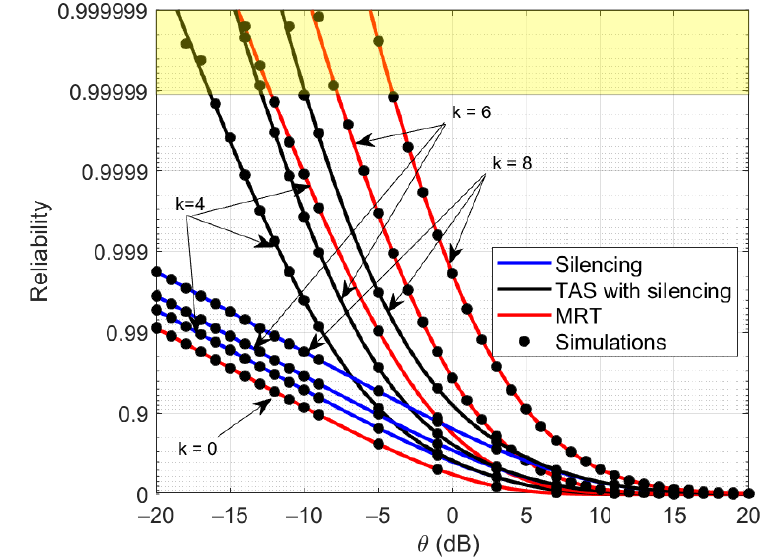
Figure 4. Overview of reliability analysis as a function of θ for silencing, TAS with silencing and MRT schemes with different level of k